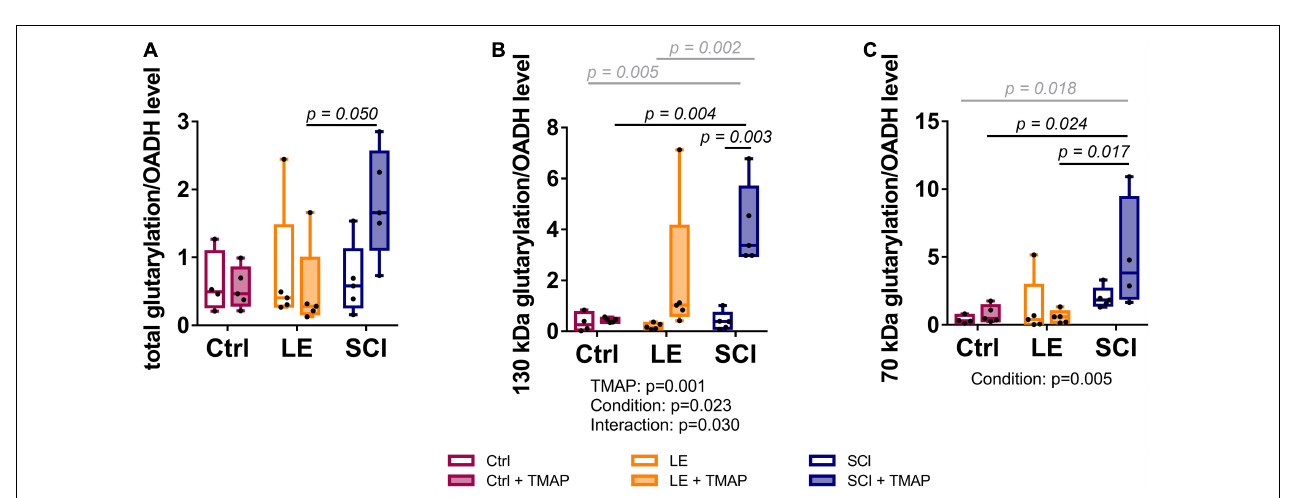
FIGURE 6 | Pearson’s correlation matrices between the brain metabolites involved in glutathione biosynthesis. Each of the three shown groups, i.e., the control, LE and SCI rats, include animals with and without administration of the OADH-directed inhibitor TMAP. Sample sizes for the estimated metabolites are indicated in the figure. In SCI, sample with n = 9 refers to the GSSG level estimation. Non-significant ( p ≥ 0.05) correlations after Holm-Bonferroni multiple testing adjustment are crossed out. The figure is created using ggstatsplot package in Rstudio.